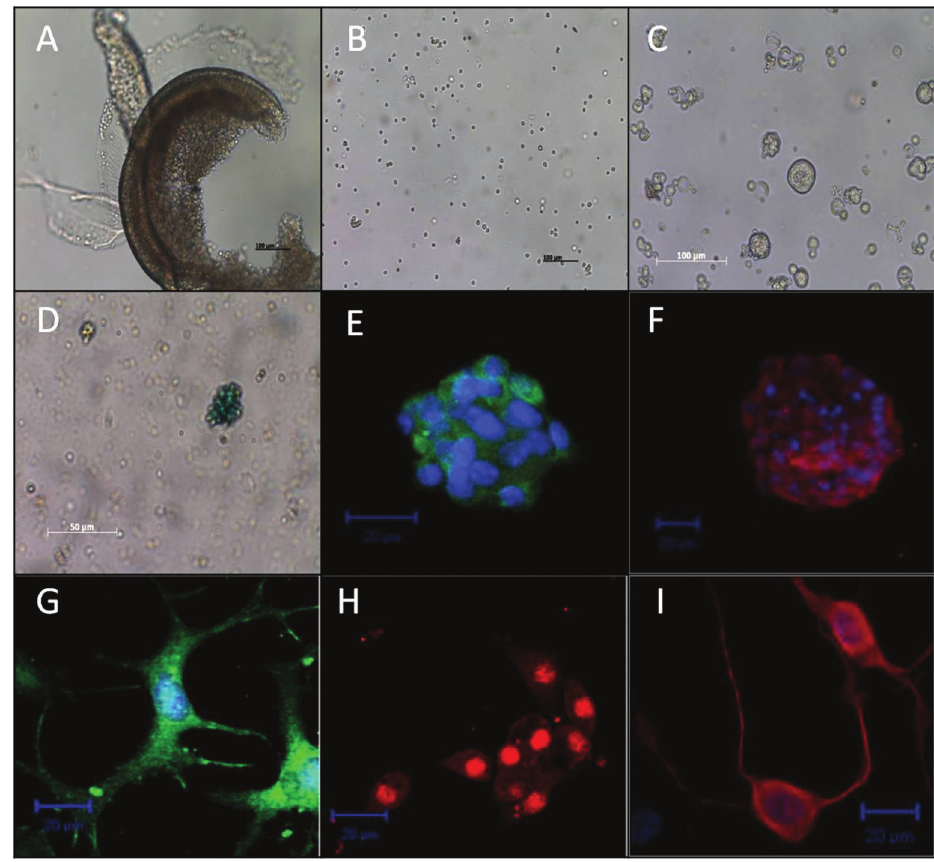
Figure 1. Mouse inner ear progenitor/stem cells (mIESCs) express stem cell markers and differentiate into cells expressing hair and supporting cell markers under certain conditions. A cochlear duct dissected from the modiolus, containing ( A ) the organ of Corti, spiral ligament/stria vascularis, and Reissner ’ s membrane. Dissociation of the organ of Corti yielded a suspension of cells as observed in culture ( B ). After 2 days in suspension culture, fl oating colonies of cells ( C ) were round and compact (solid spheres). LacZ -lentivirus- transduced mIESCs were discerned by blue staining ( D ) in X-gal assays. Under suspension culture conditions ( E – F ), spheres contained cells expressing Sox2 ( E , green) or nestin ( F , red), markers of pluripotency and neural stem cells, respectively. Upon